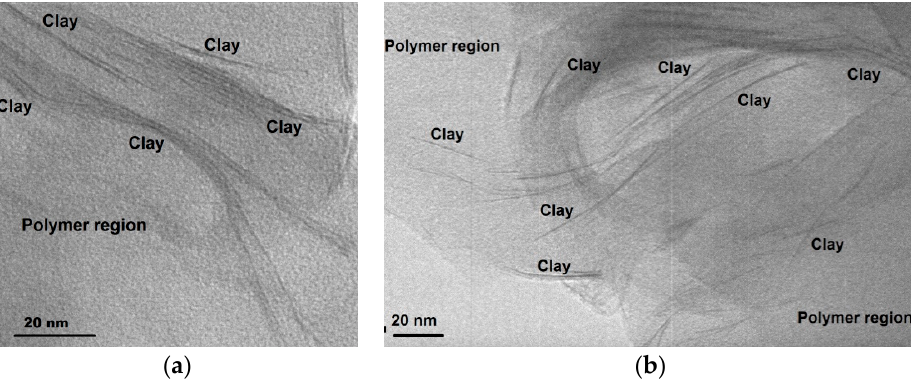
Figure 1. Transmission Electron Microscopy (TEM) images of poly(methyl methacrylate) (PMMA) nanocomposites containing 1 wt % Cloisite 15A ( a ) and 2 wt % Cloisite 15A ( b ).